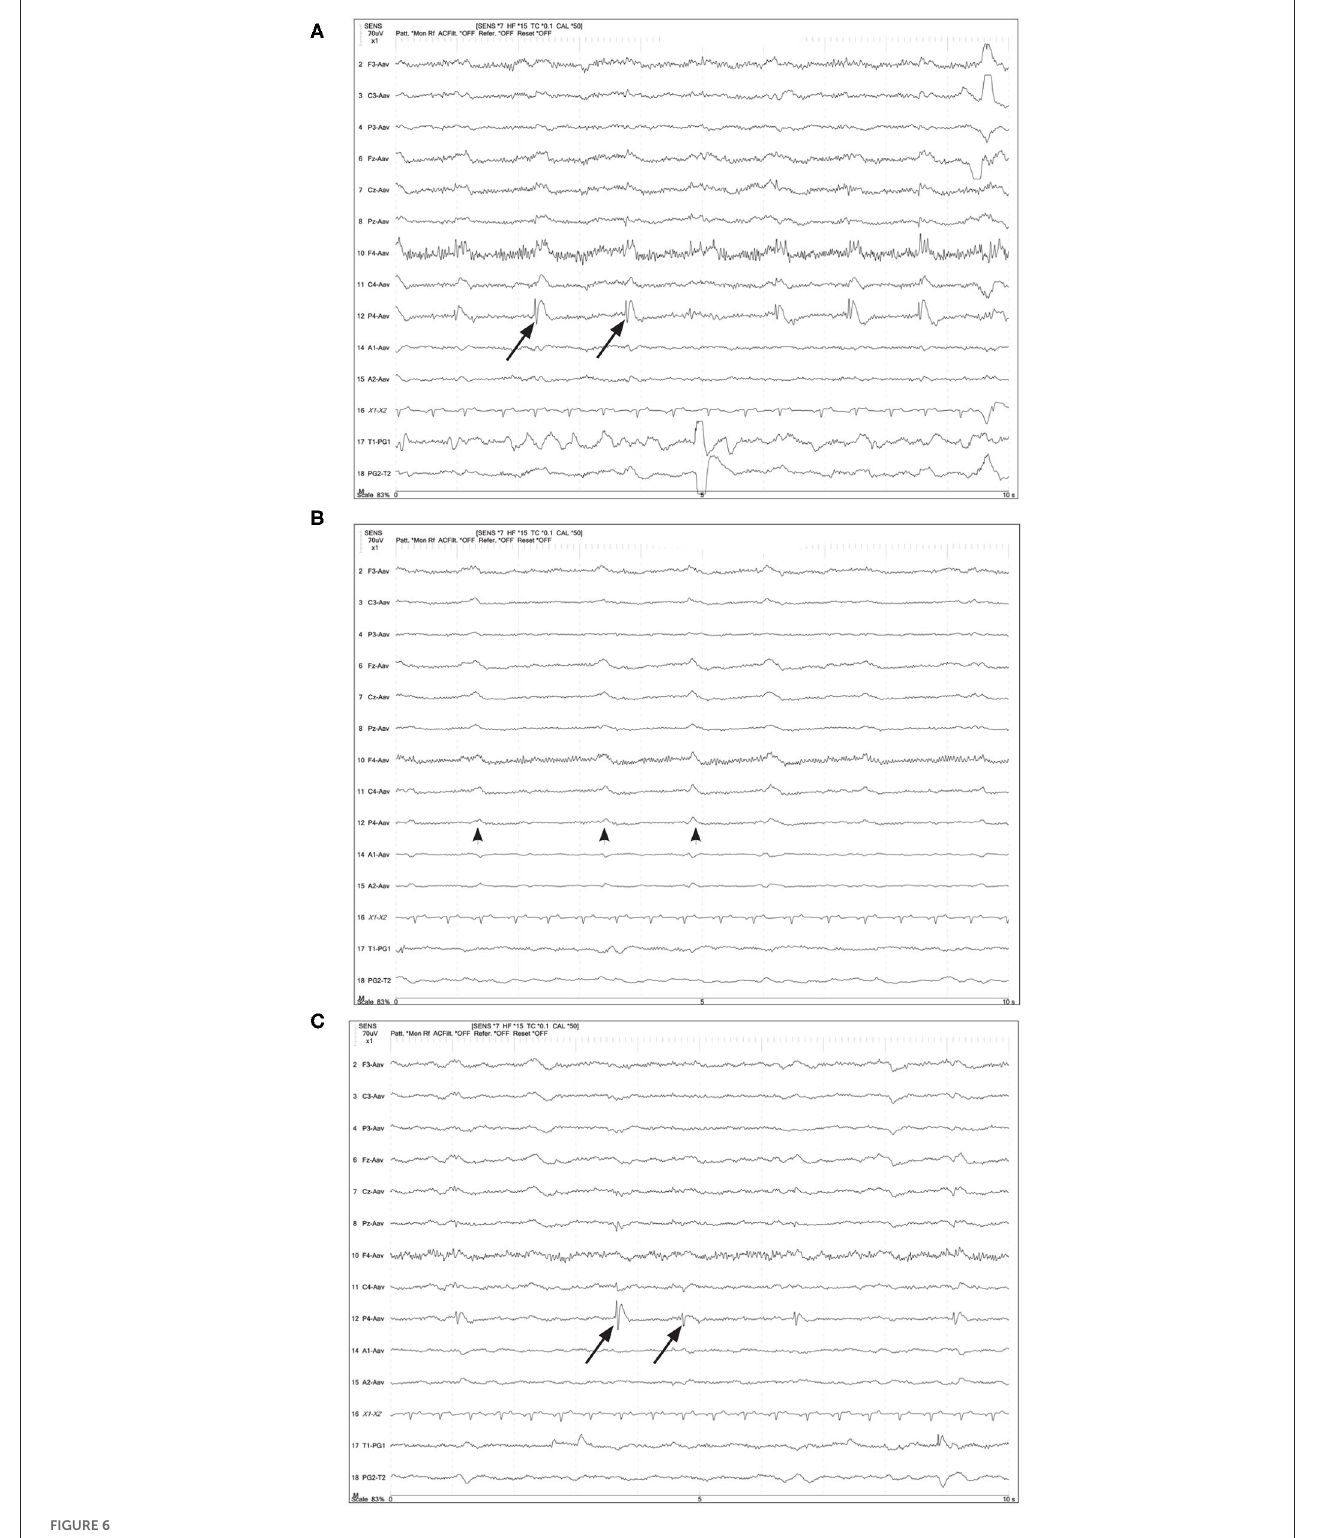
FIGURE6 Four year old German Shepherd with cluster seizures and HE. Referential montage; HF 15Hz, sensitivity 5 uV/mm in all panels. (A) Right parietal LPDs (arrows) with spike-wave morphology, immediately prior to IV midazolam (MDZ). (B) Shortly after IV MDZ, the LPD morphology is changed to more blunted and lower amplitude (arrowheads), but still noted on the right hemisphere and midline chain. (C) Ten minutes post-MDZ, the LPDs at P4 (arrows) have returned to the spike-wave